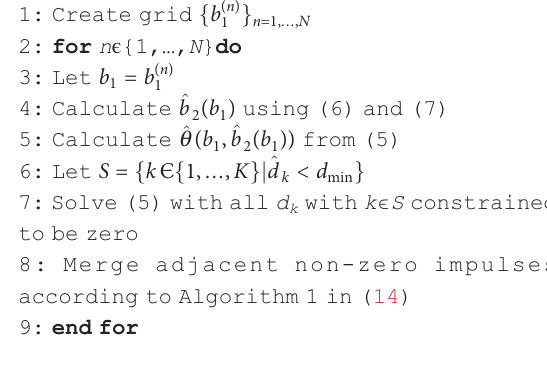
ALGORITHM 1 Impulse and time constant estimation.